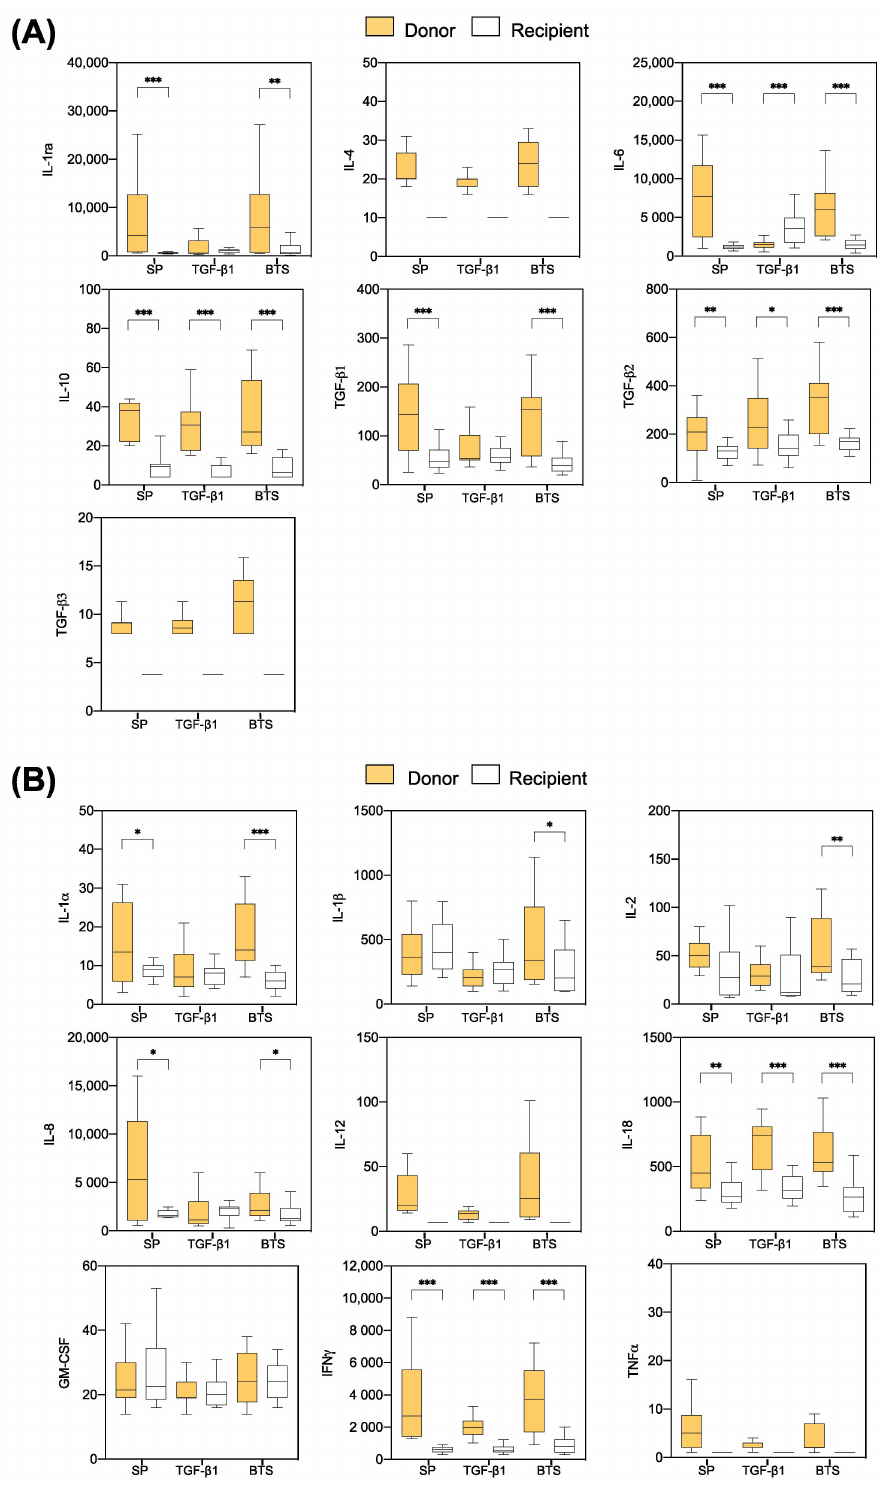
Figure 5. Differences found six days after the onset of estrus in endometrial anti-inflammatory ( A ) and pro-inflammatory ( B ) cytokine levels between “donors” and “recipients” infused with 40 mL of SP, TGF- β 1 in BTS extender (TGF- β 1), or BTS alone (control) 30 min prior to insemination. The box plots show the median (line) and the interquartile ranges (boxes, Q1–Q3). * p < 0.05, ** p < 0.01, *** p <